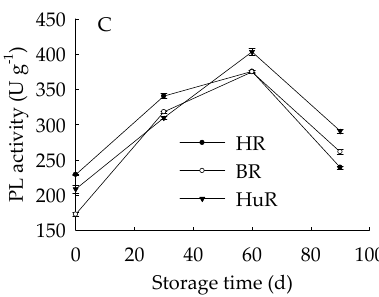
Figure 5. Changes in activities of polygalacturonase (PG) ( A ), pectinesterase (PE) ( B ), and pectate lyase (PL) ( C ) in juice sacs of HR, BR and HuR during postharvest storage. Vertical bars represent SE of the means of three replicate assays.